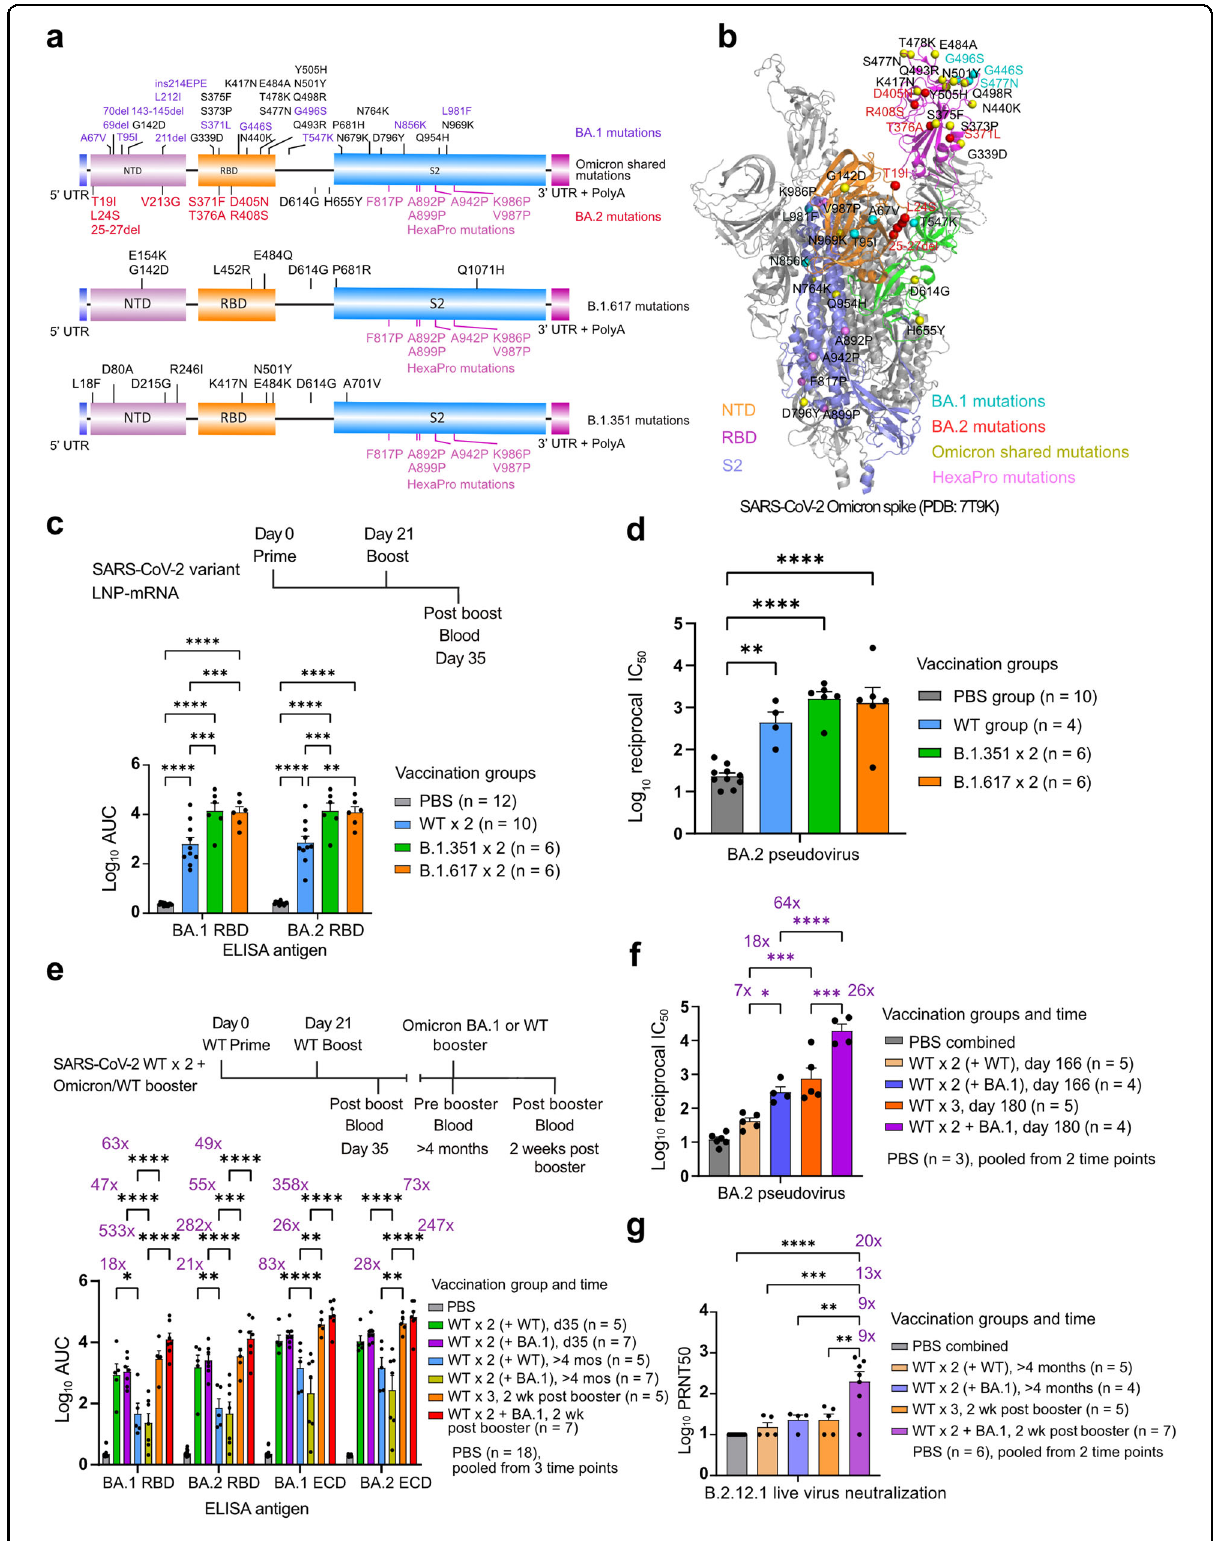
Fig. 1 (See legend on next